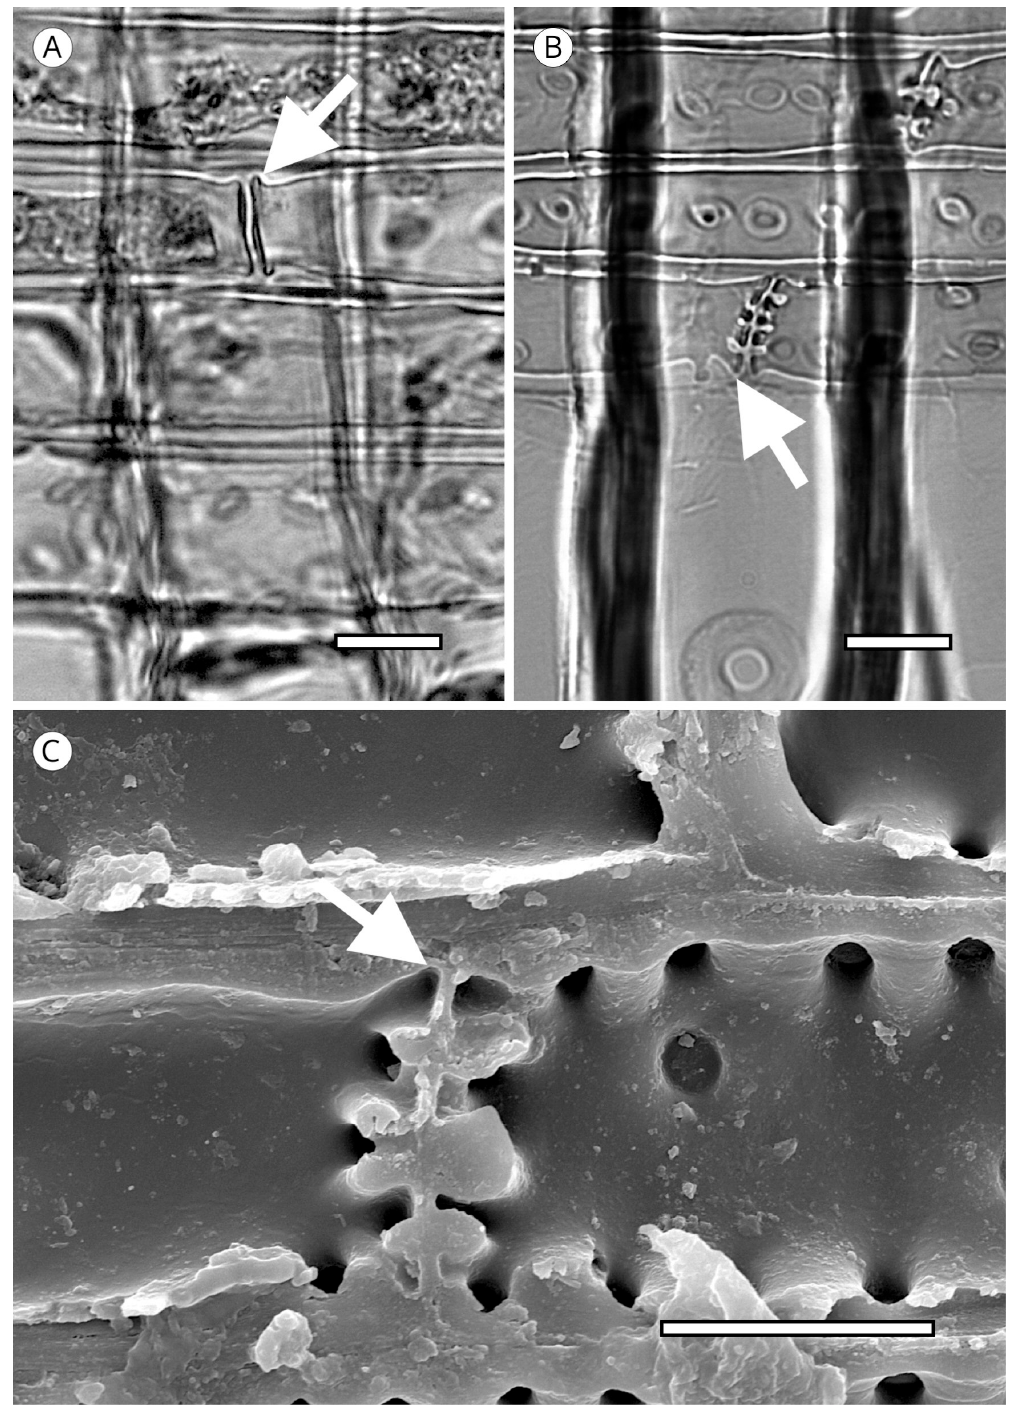
Figure 34. Indentures. ( A ) Calocedrus decurrens (Torr.) Florin; ( B ) Abies cilicica (Antoine & Kotschy) Carri è re; ( C ) Abies lasiocarpa (Hook.) Nutt. (SEM). Scale bars. ( A – C ) = 25 µ